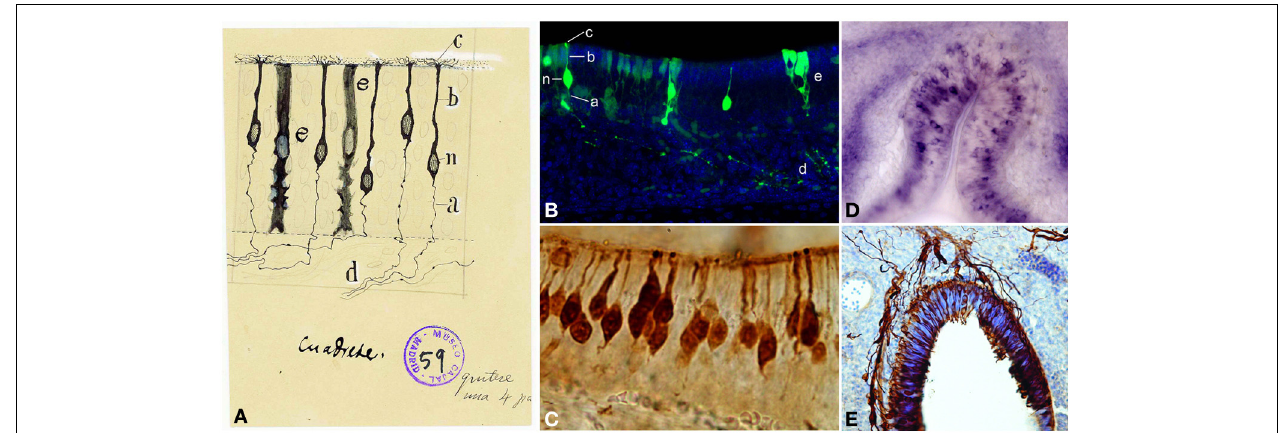
FIGURE 3 | Olfactory sensory neurons (OSNs). (A) Cajal drawing illustrating the cell types and their morphologies in the olfactory epithelium. OSN components: (n) nucleus; (b) dendrite; (c) apical cilia; (a) axon. (d) OSNs axons bundle. (e) supporting or sustentacular cell. The drawing shows the handwriting of Cajal with specific instructions for the required reduction publication factor in the margins (Ramón y Cajal, 1917). Cajal Legacy (Instituto Cajal, CSIC, Madrid, Spain). (B) Olfactory epithelium labeled E18 cells after in utero electroporation of an